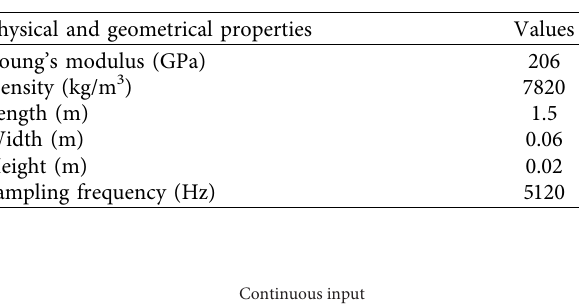
Table 2: Parameters of the cantilever beam model.